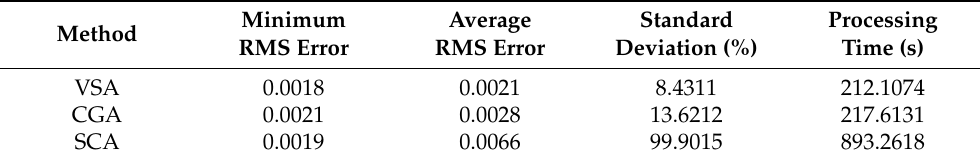
Table 1. Resuls obtained by the master–slave optimization methdologies